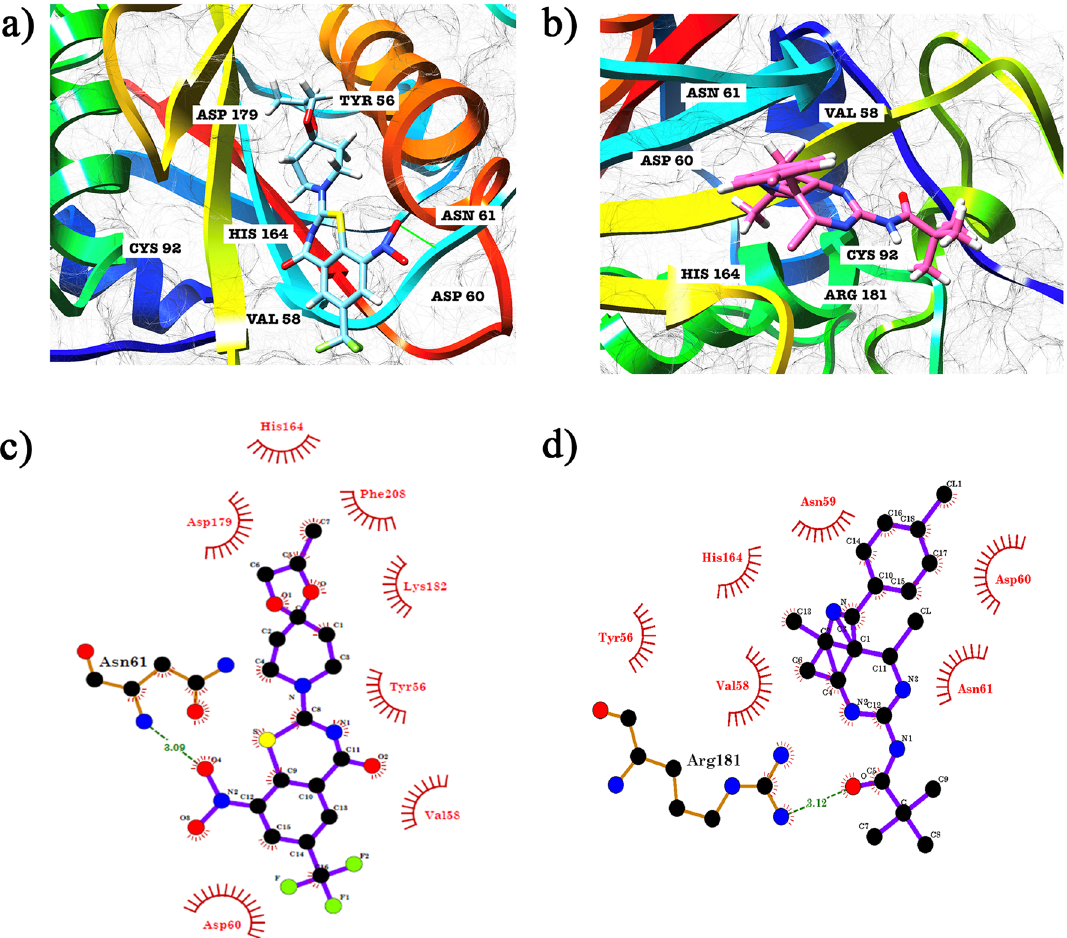
Figure 5. The two lead molecules docked to the active site cleft of PfUCHL3 (PDB ID: 2WE6): cartoon representation of predicted binding of ( a ) MMV676603 and ( b ) MMV688704 with PfUCHL3. 2-D ligand interaction maps of ( c ) MMV676603 and ( d ) MMV688704. Green lines depict hydrogen bonds and eye shaped residues exhibit hydrophobic